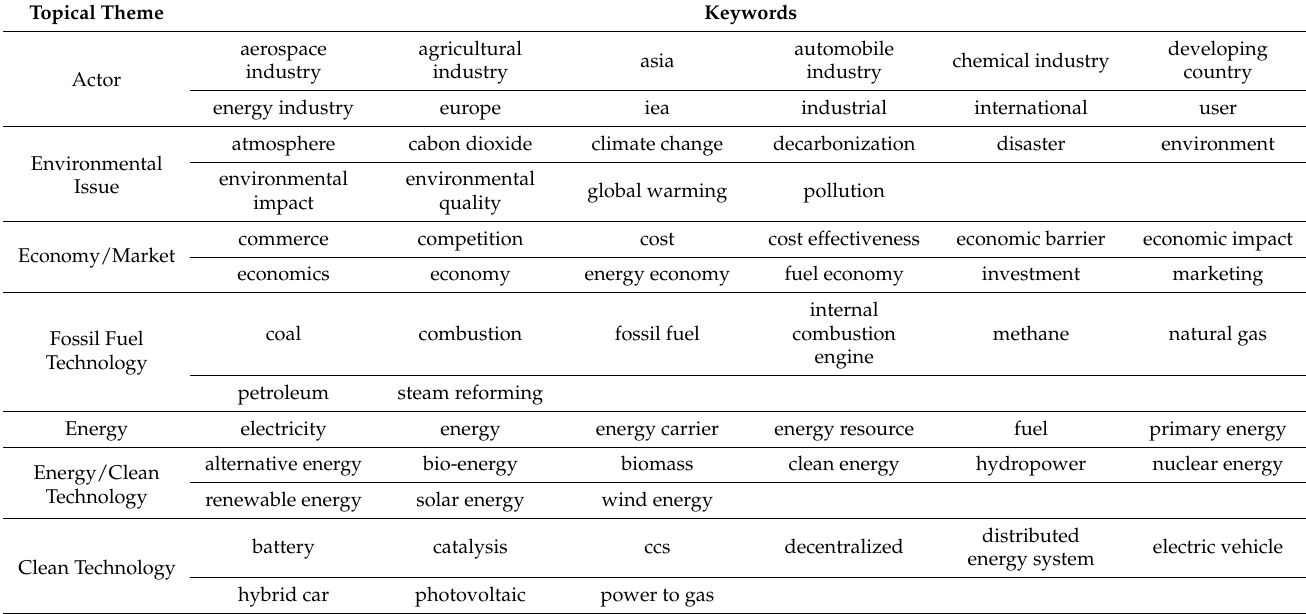
Table A2. Topical themes and specific keywords in keyword co-occurrence